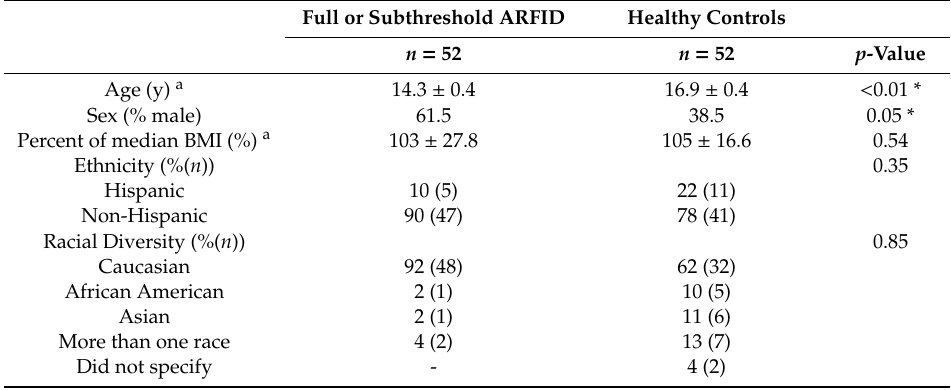
Table 1. Clinical characteristics of participants with full or subthreshold avoidant / restrictive food intake disorder (ARFID) and healthy